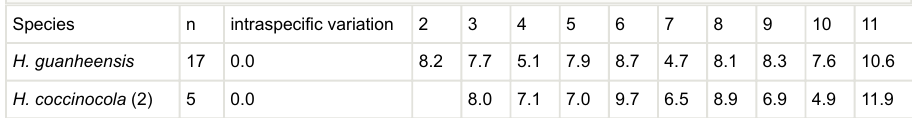
Pairwise comparisons of genetic distance of nine Homatula species, based on K2P model from sequences of the COI gene, with number of sequences per species (n), the intraspecific variation, followed by the distance between species (in